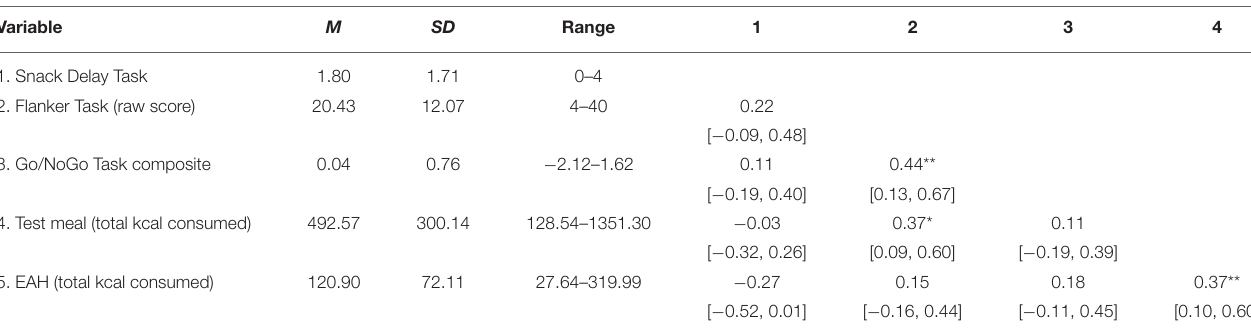
TABLE 2 | Descriptive data of self-regulation, test meal, and EAH variables, and correlations with confidence intervals. Variable M SD